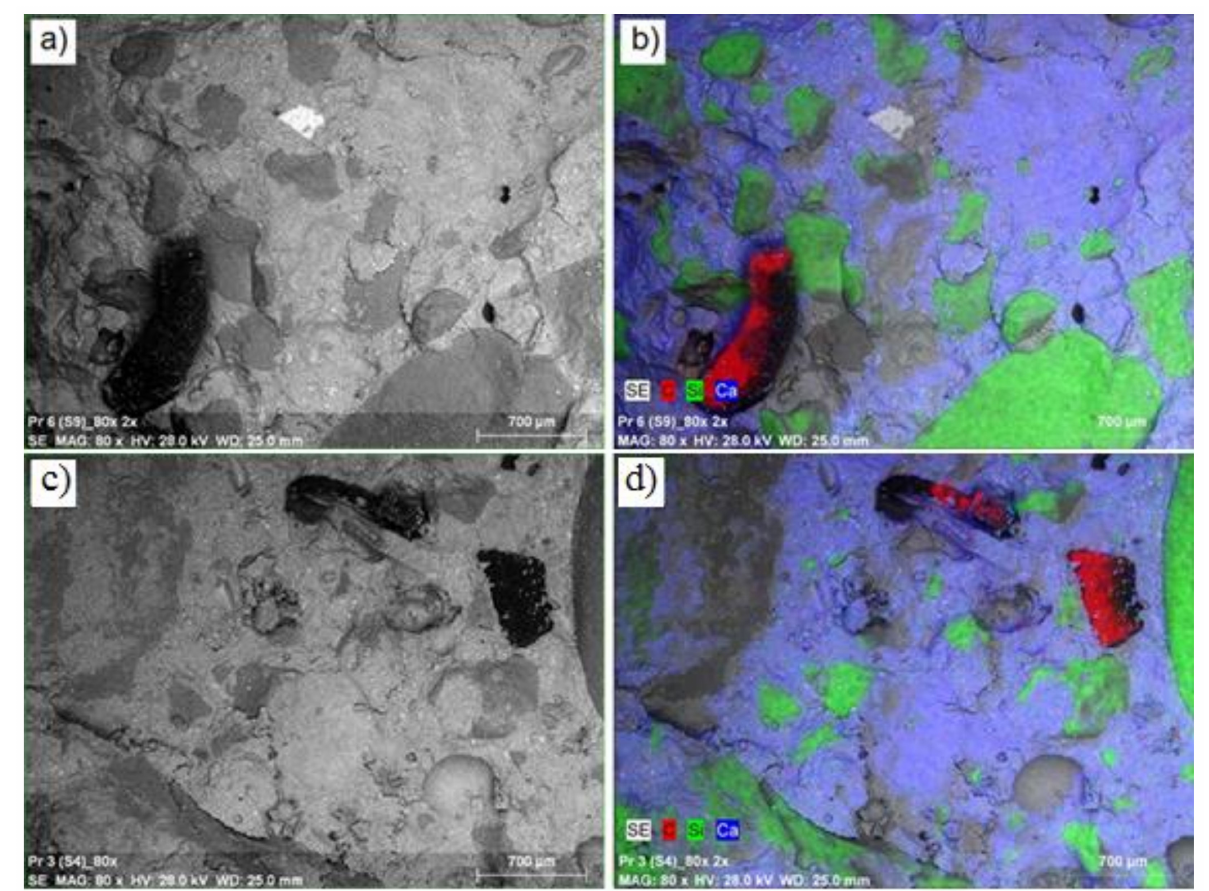
Figure 5. Concrete microstructure: ( a ) reference series S1-1 enlarged by 80 × ; ( b ) location map of the dominant elements in a given area, concrete series S1-1; ( c ) series S1-4 enlarged by 80 × ; ( d ) location map of the dominant elements in a given area, concrete series